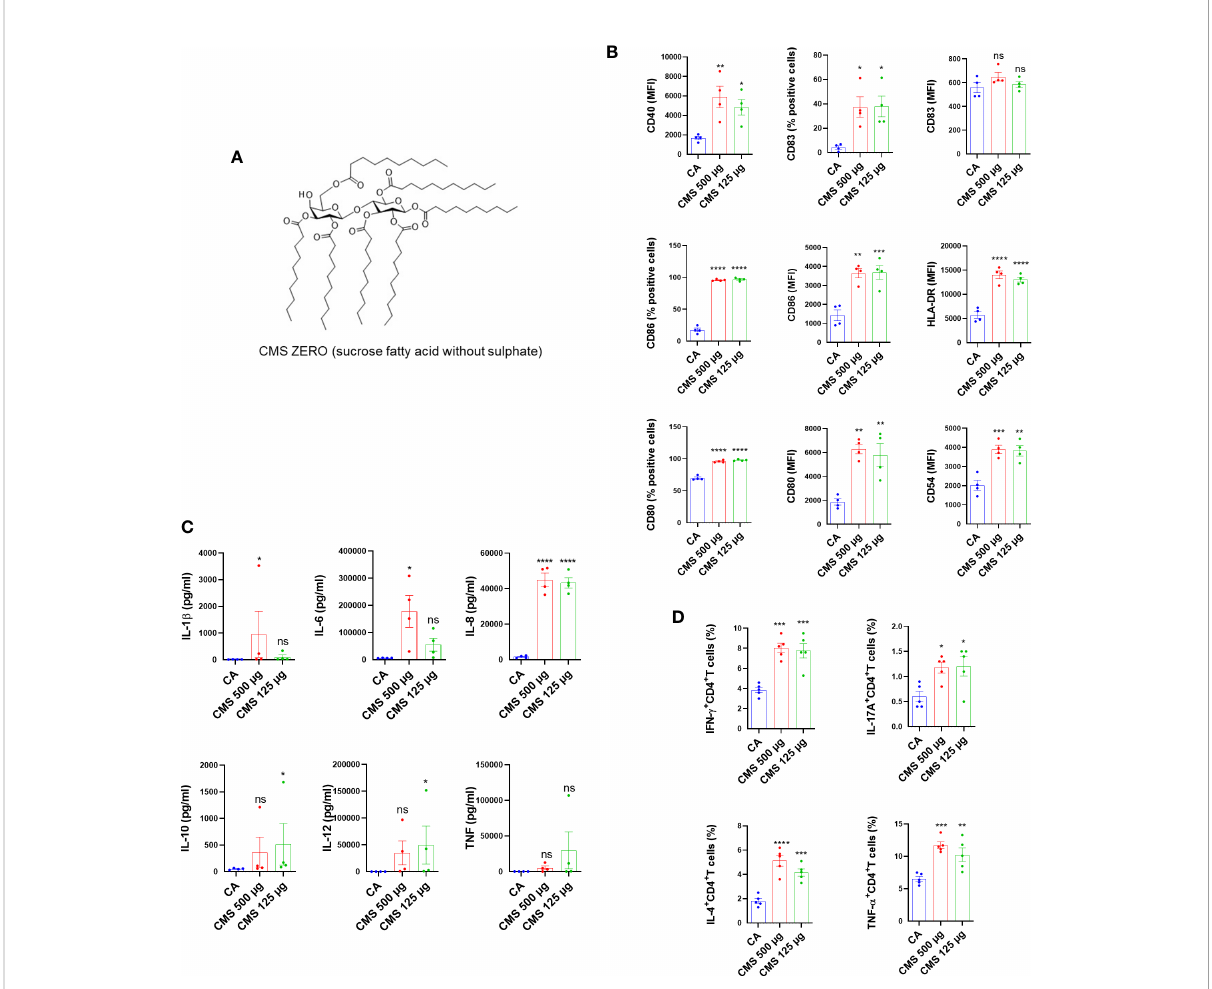
FIGURE 2 Identi fi cation of the component responsible for the immunostimulatory activity LiteVax ™ (LVA) adjuvant on human dendritic cells. (A) CMS Zero (sucrose fatty acid without sulphate). (B) Effect of CMS on the expression of surface markers of human dendritic cells. Monocyte – derived dendritic cells (0.5x10 6 cells were cultured with GM – CSF/IL – 4 and were treated with either CMS 500 µg/ml, CMS 125 µg/ml for 48 h. The phenotype of dendritic cells was analyzed by fl ow cytometry. Data present values of expression (% positive cells or median fl uorescence intensities, MFI) of CD40, CD54, CD80, CD83, CD86 and HLA – DR. Data are from n=4 donors with two independent experiments and are presented as mean ± SEM. (C) Secretion of cytokines (mean±SEM, n=4) of IL – 1 b , IL – 6, IL – 8, IL – 10, IL – 12p70, and TNF – a (all in pg/ml) by treated dendritic cells. (D) Effect of CMS on the dendritic cell – mediated CD4 + T cell responses. Dendritic cells were cultured with GM – CSF/IL – 4 and were treated CMS 500 µg/ml or CMS 125 µg/ml for 48 h. Dendritic cells were washed and co – cultured with puri fi ed allogeneic CD4 + T cells (1:10 ratio) for six days. After six days, cells were subjected to staining for the intracellular cytokines for Th1 (IFN – g + CD4 + ), Th17 (IL – 17A + CD4 + ), Th2 (IL – 4 + CD4 + ) cells, and TNF – a – secreting CD4 + T cells (TNF – a + CD4 + ). Data were presented as mean ± SEM (n=5 independent donors with three independent experiments). Statistical signi fi cance as determined by one – way ANOVA with Dunnett ’ s multiple